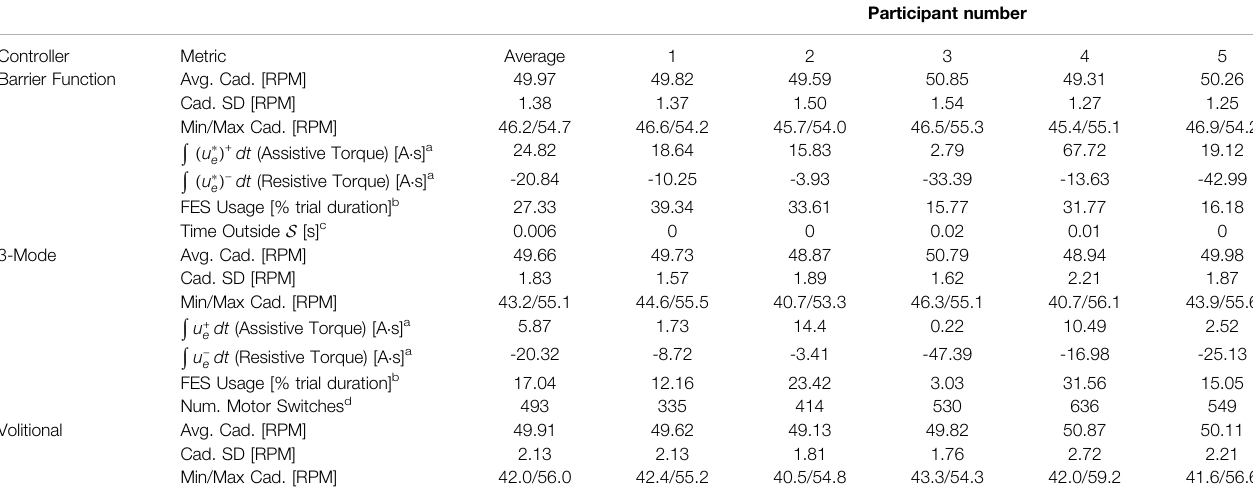
Participant number